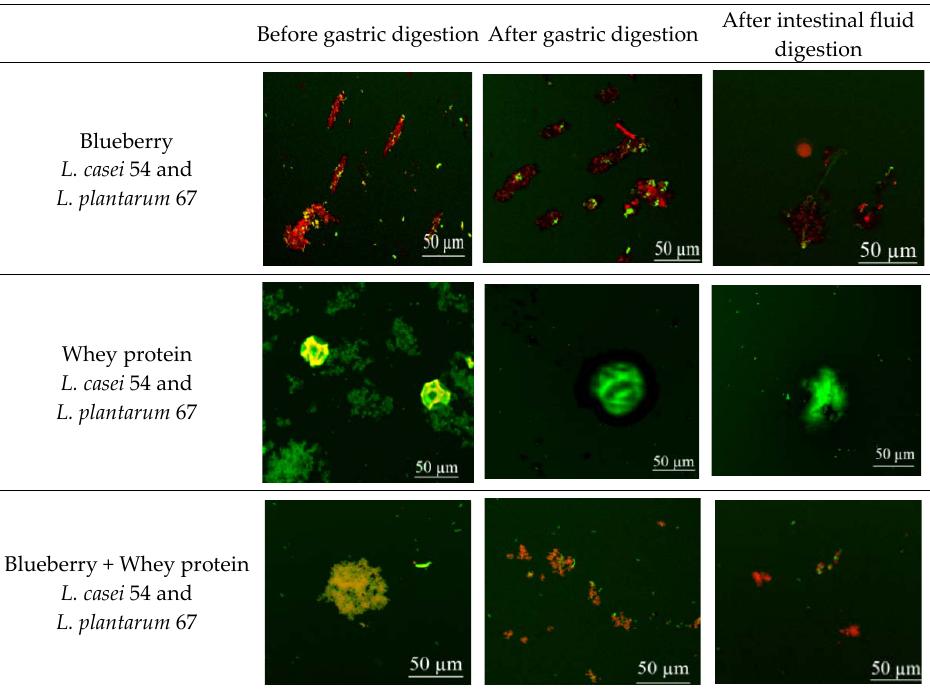
Figure 5. CLSM pictures of the dynamic release of anthocyanins and distribution of the probiotics during in vitro gastrointestinal digestion. Proteins: the voluminous structures with green color; anthocyanins: red color; probiotics: fluorescent bacillus and chain-shaped structures with green color. The magnification of whey protein was 20× and the magnification of other samples was 100×.